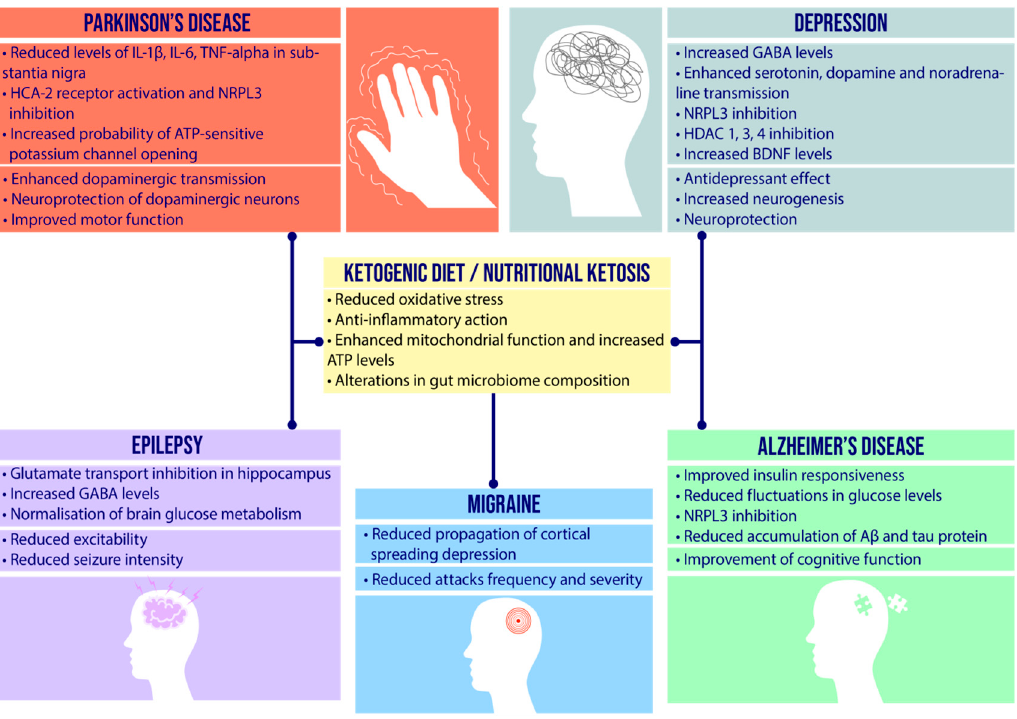
Figure 4. The potential role of the ketogenic diet/nutritional ketosis in neurological disorders. The large amount of ketone bodies formed during a low-carbohydrate, high-fat diet may have a beneficial effect on many of the pathological processes found in neurological diseases, thus potentially offering beneficial adjuvant therapy. (IL-1 β : interleukin 1 β ; IL-6: interleukin 6; TNF-alpha: tumour